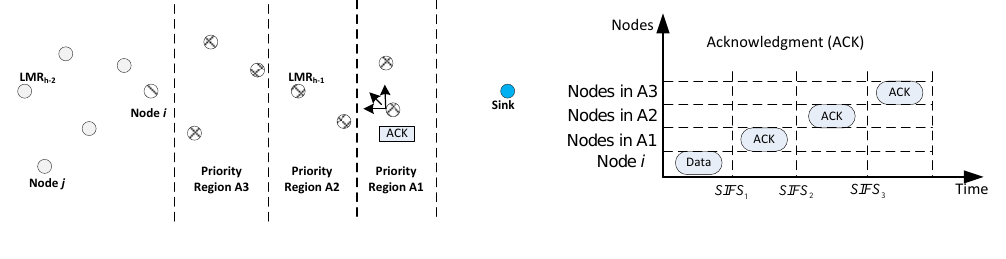
Figure 6. Receiver contention prioritization and backoff